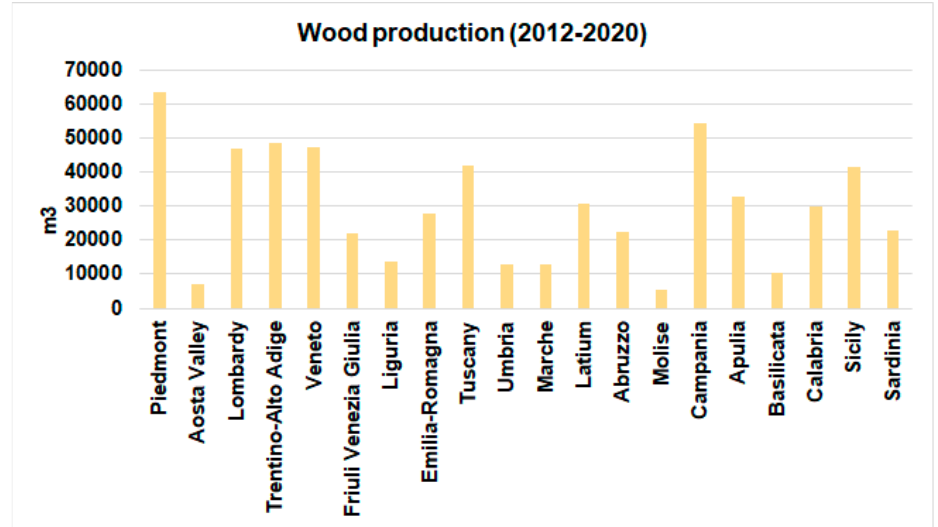
Figure 6. Estimation of wood production loss (m 3 ) due to land consumption in the period 2012–2020 at the regional level.